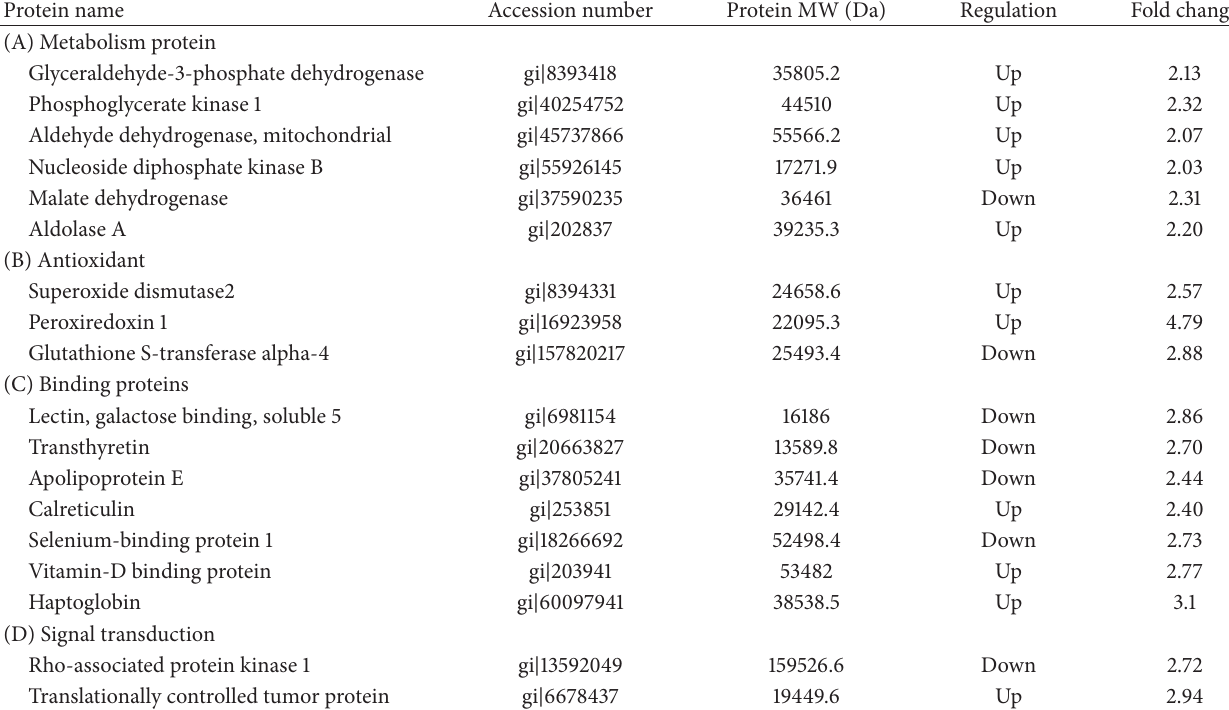
Table 2: The classification of differential proteins in ALI lung tissue with the comparison of control